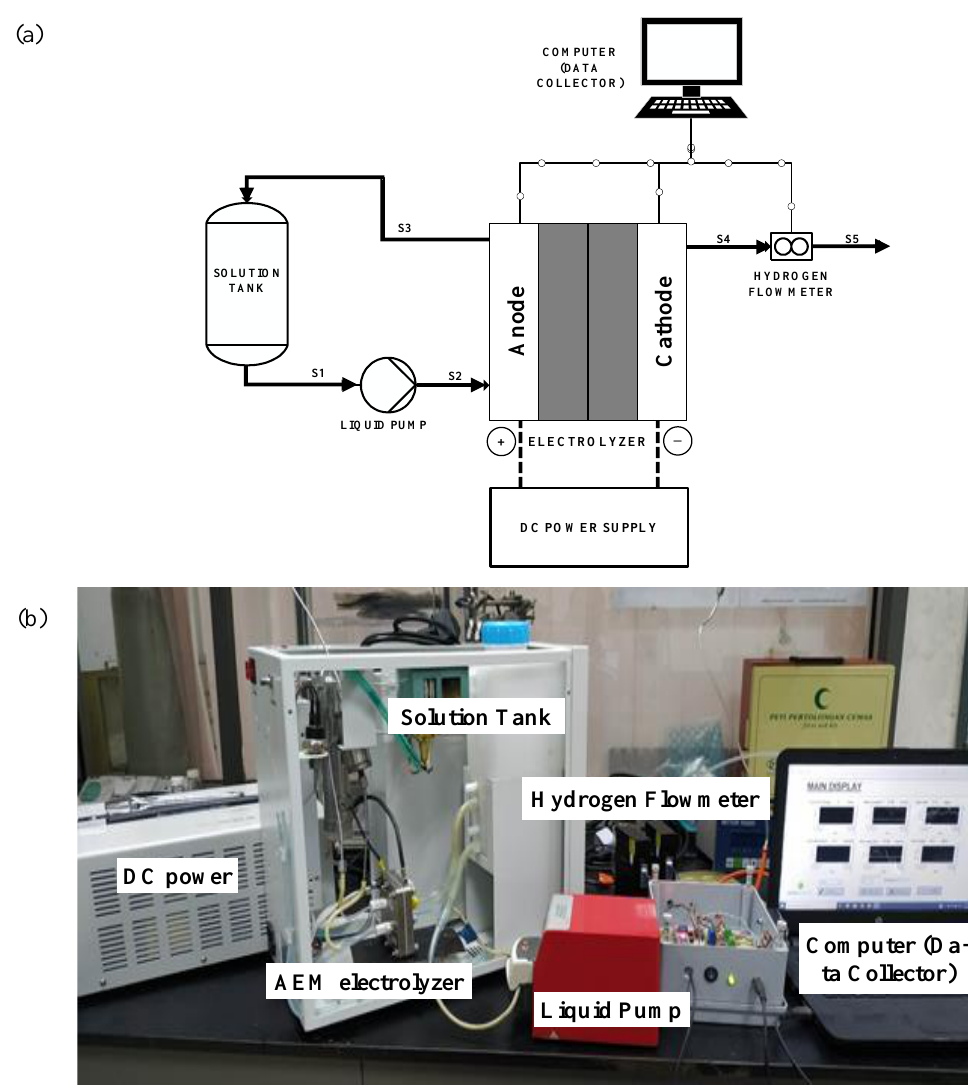
Figure 1. AEM electrolysis setup. ( a ) Schematic diagram. ( b ) Actual photo.